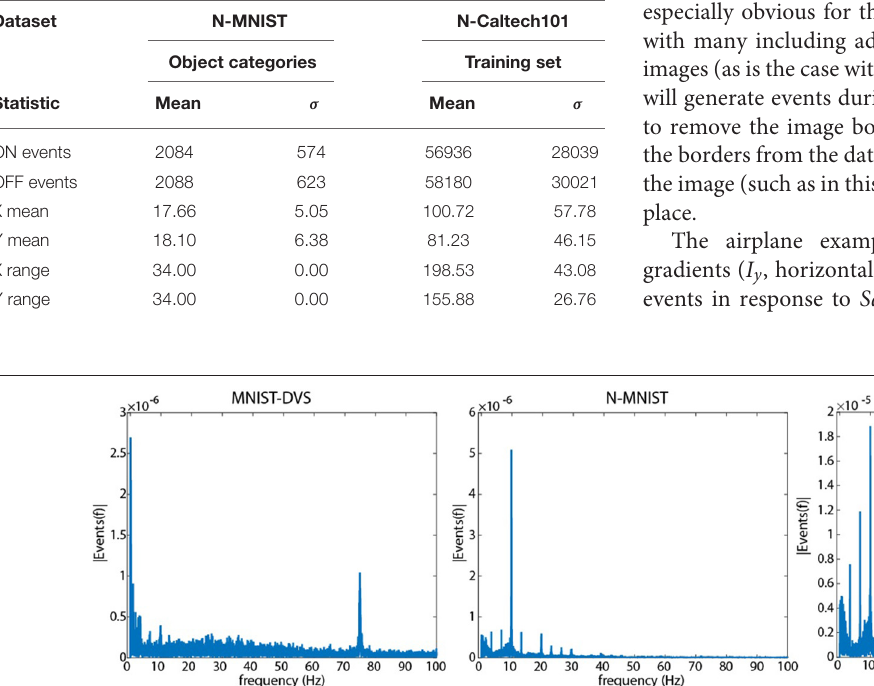
TABLE 2 | Statistics of the dataset recordings which were used for classification. Dataset